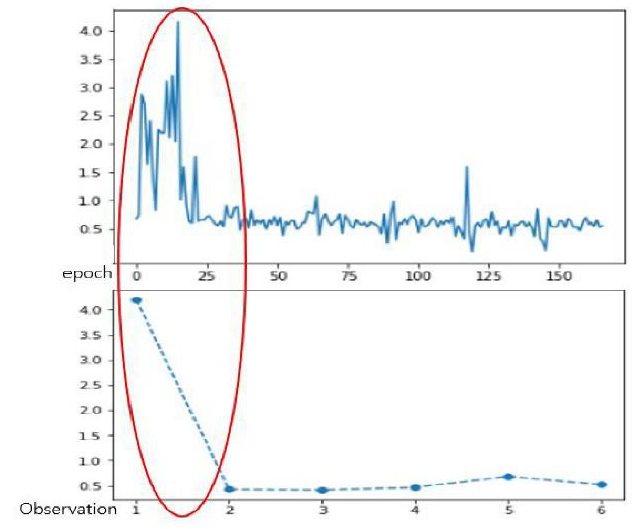
Figure 6. Temperature variability over the measurement.